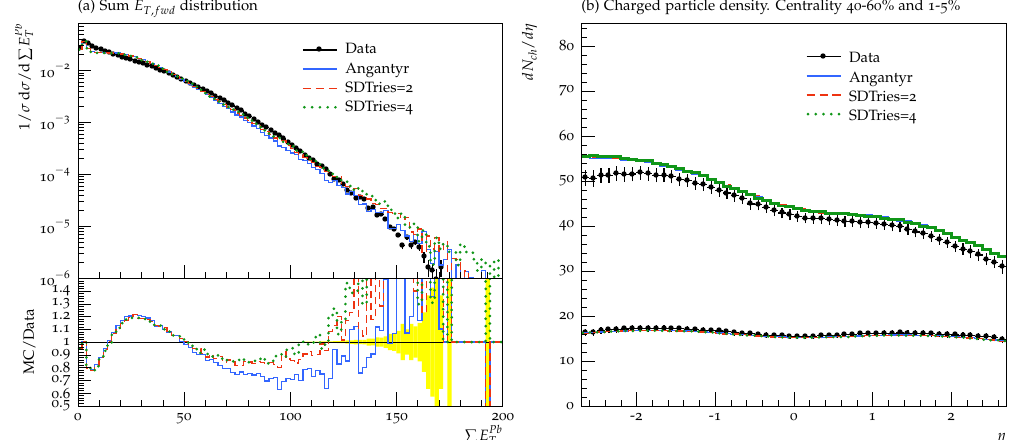
Figure 25 . Same as (cid:12)gure 23, but now varying the number of attempts (parameter Angantyr:SDTries ) allowed to generate secondary sub-events that can be added without violating energy-momentum conservation before giving up and vetoing the secondary interaction. The de- fault version allows only a single attempt and is shown as the blue lines, while allowing two or four attempts is shown as dashed red and dotted green lines